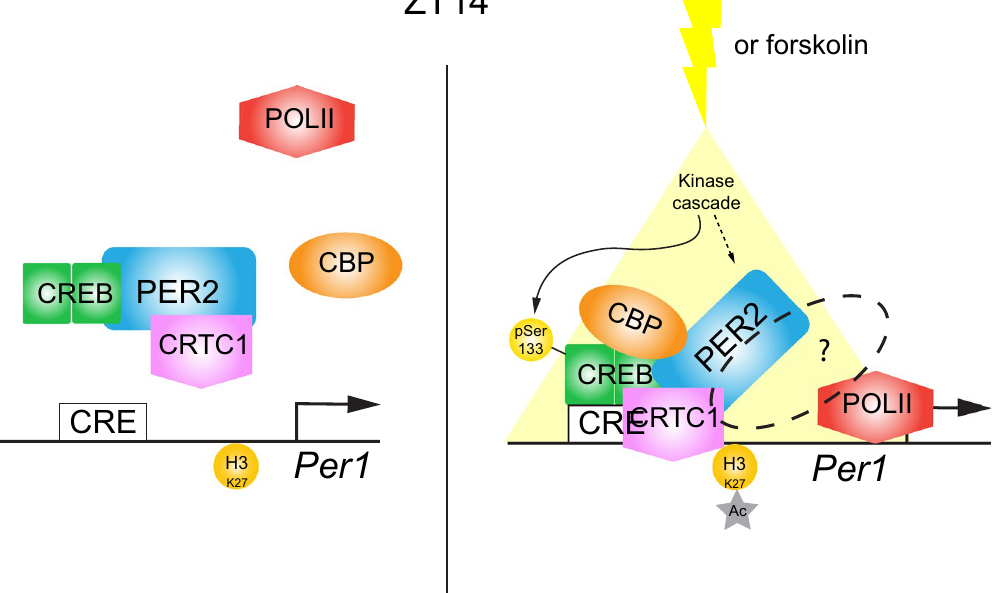
Figure 7. Model of PER2 modulating the assembly of the CREB/CRTC1/CBP transcriptional complex. Left: In the early dark phase at ZT14, PER2 interacts with CREB and CRTC1. On the other hand, CREB and CRTC1 do not dimerize at this stage, and all the elements do not bind to the CRE element in the Per1 promoter. CBP is not recruited to the regulatory region of Per1 and the histone H3K27 is not acetylated. Per1 is not transcribed through this pathway. Right: In the SCN or in cells a light pulse or forskolin treatment initiates a kinase cascade that leads to CREB phosphorylation and assembly of the CREB: CRTC1: CBP complex which is facilitated by PER2. As a consequence of this assembly, histone H3K27 is acetylated (grey star) and the Per1 gene is transcribed. The hatched oval with question mark indicates that most likely additional factors contribute to the initiation of transcription by the RNA polymerase II (POLII). Figure was generated using Adobe Illustrator version